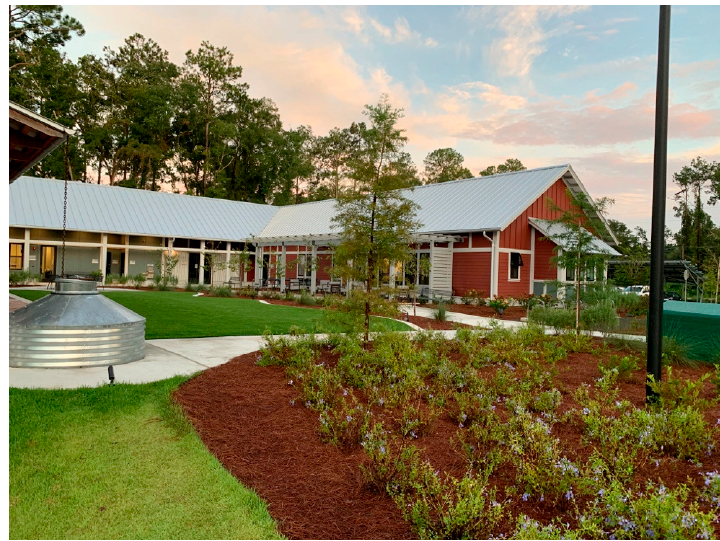
Figure 7. The Dwellings community center.